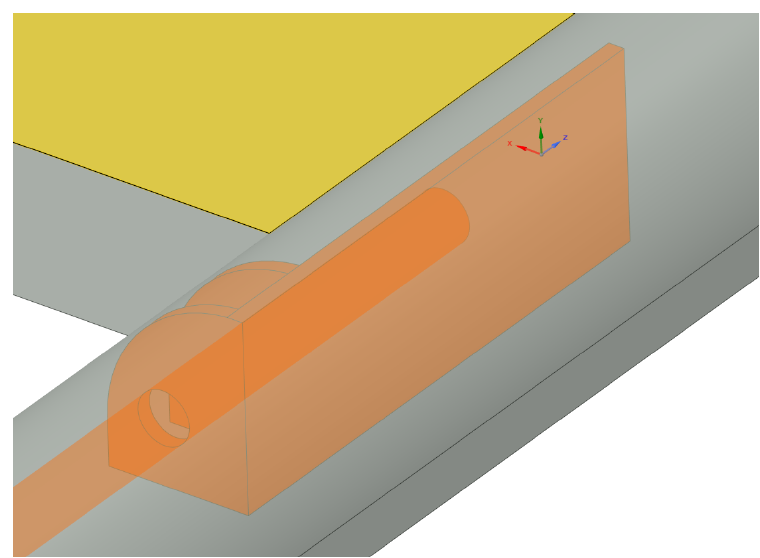
Figure 4. Design of the brattice and location of the auxiliary air-duct outlet. The primary solver settings are summarized in Table